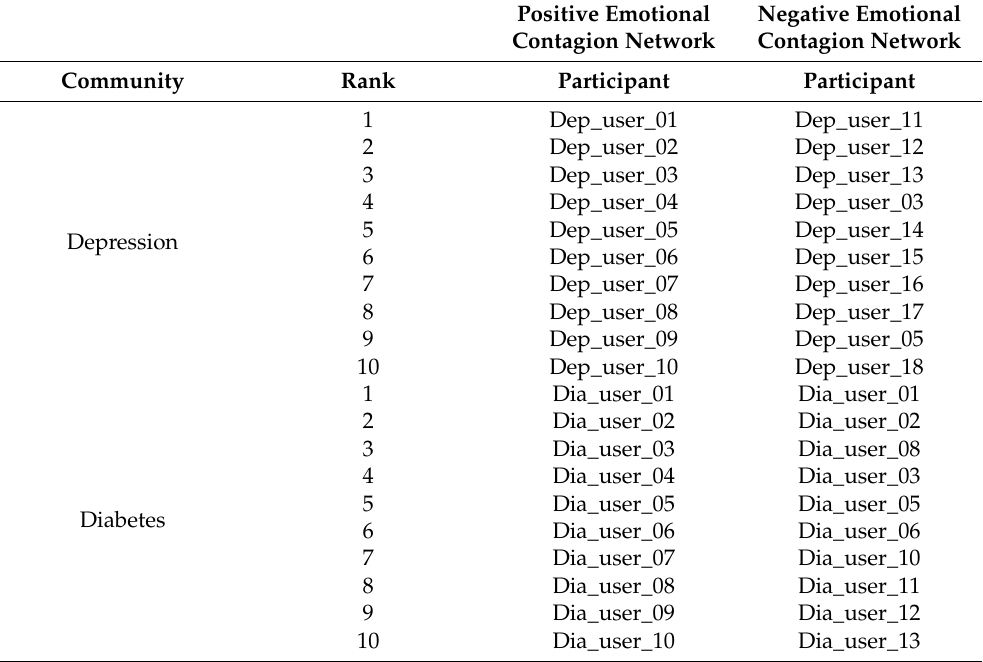
Table 5. Top 10 participants in subnetworks sorted by out